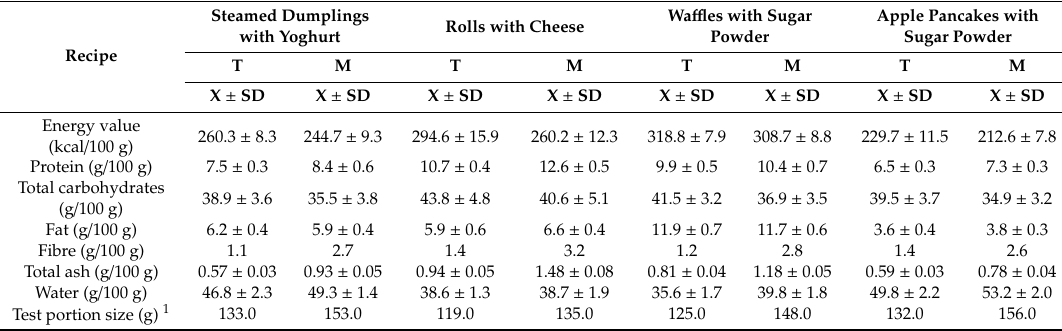
Table 1. The energy value and nutrient composition of the investigated meal (per 100 g) and that provided in portion size of 50 g digestible